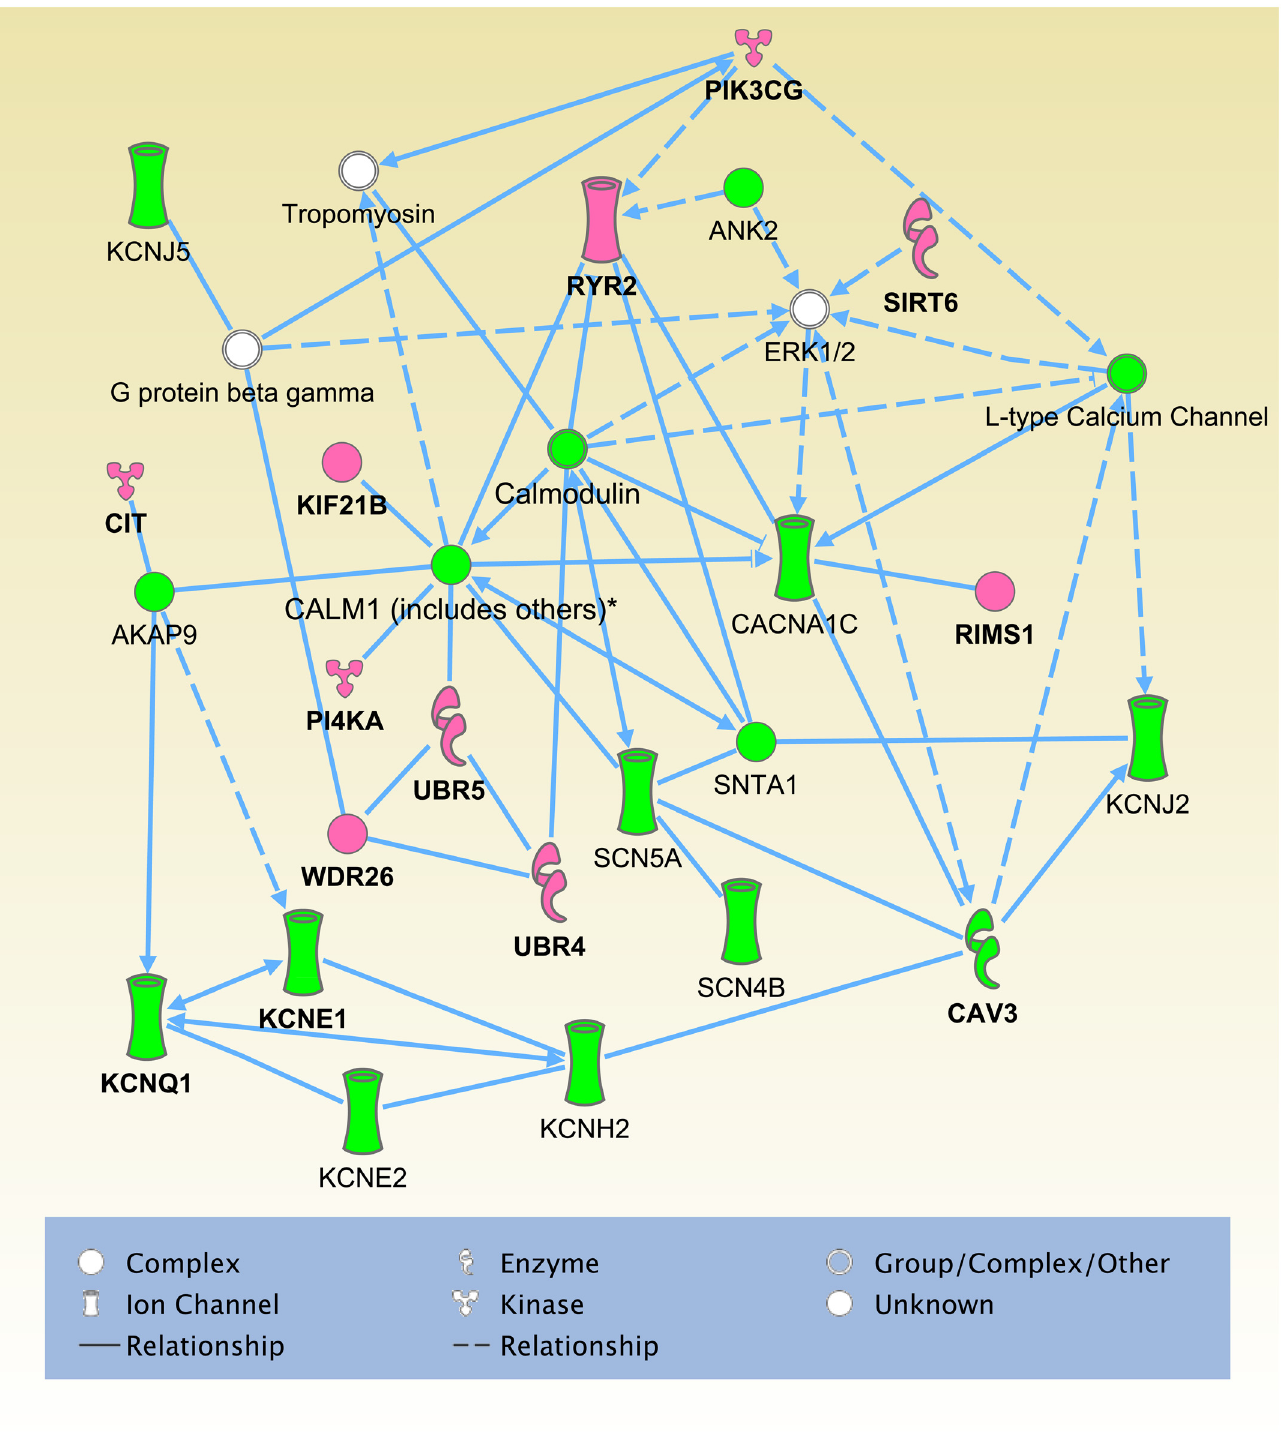
Fig 2. The top-scoring IPA network constructed on the basis of known genes/proteins and candidate pathogenic genes/proteins identified. The green and pink objects represent known LQTS genes and candidate pathogenic genes identified in this PPI analysis, respectively.